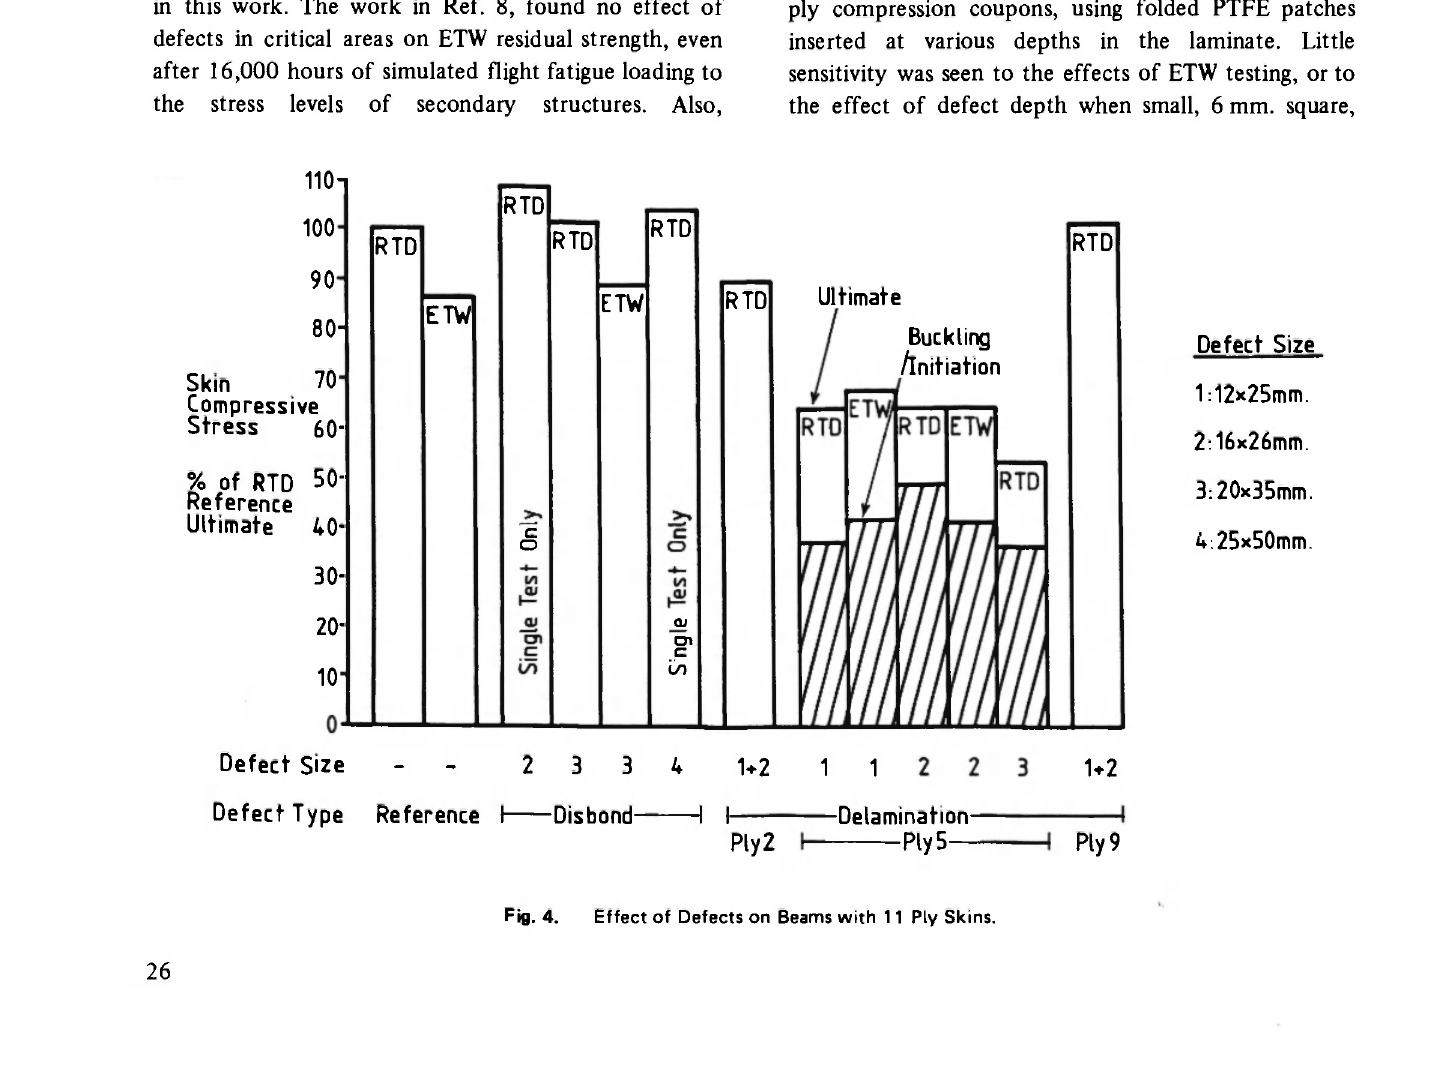
Fig. 4. Effect of Defects on Beams with 11 Ply